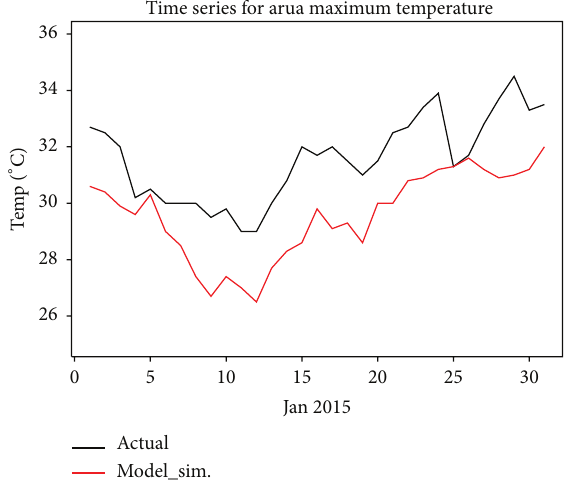
Figure 1: Arua: max temp. Figure 2: Arua: min temp.